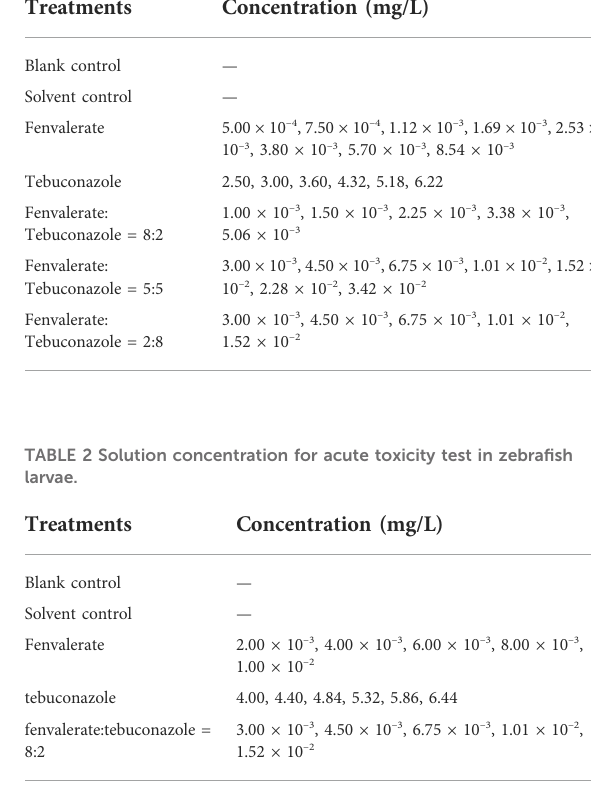
TABLE 1 Solution concentration for acute toxicity test in zebra fi sh adults. Treatments